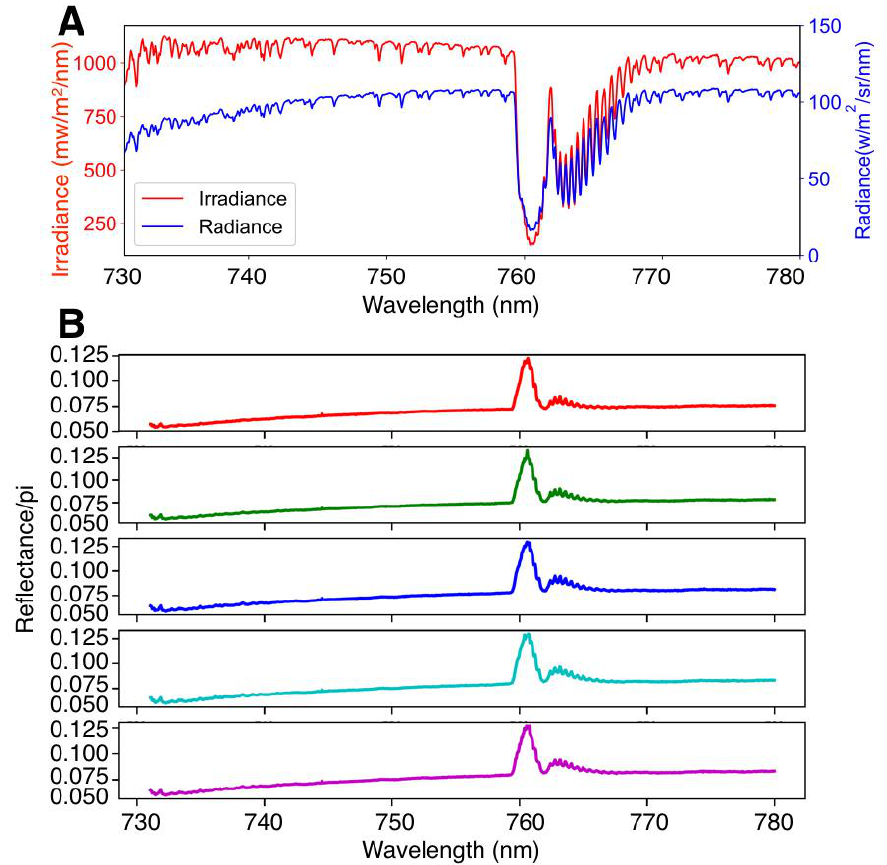
Figure 5. Kautsky Effect detected by FluoSpec 2 in the lab using a blue light-emitting diode (LED) light.